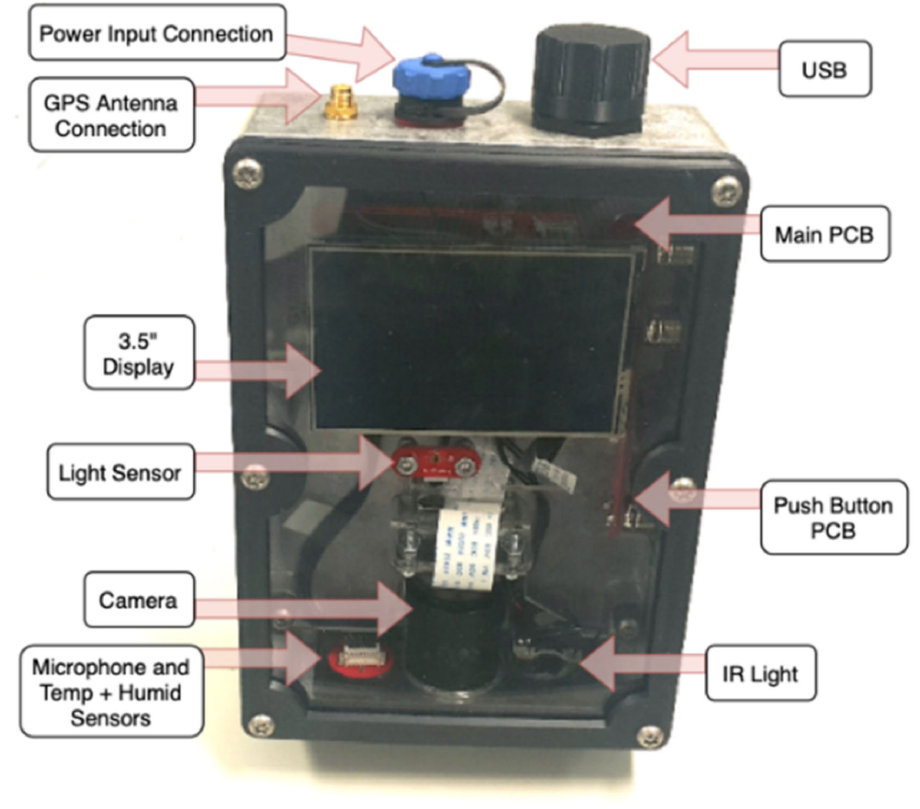
Figure 5. Completed camera